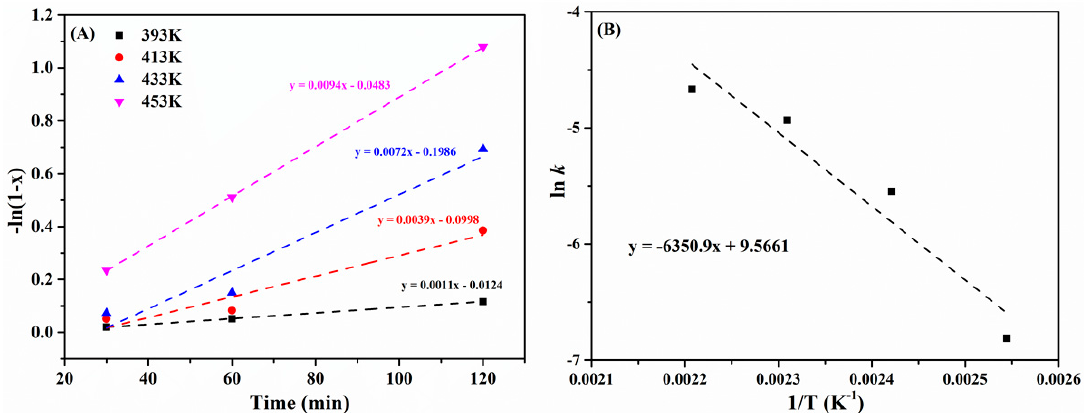
Figure 8. ( A ) Kinetic profiles, and ( B ) Arrhenius plot of the PPOA–Hf-1:1.5-catalyzed conversion of EL to GVL. Reaction conditions: EL, 1 mmol; PPOA–Hf-1:1.5, 72 mg; and 2-propanol, 5 mL.